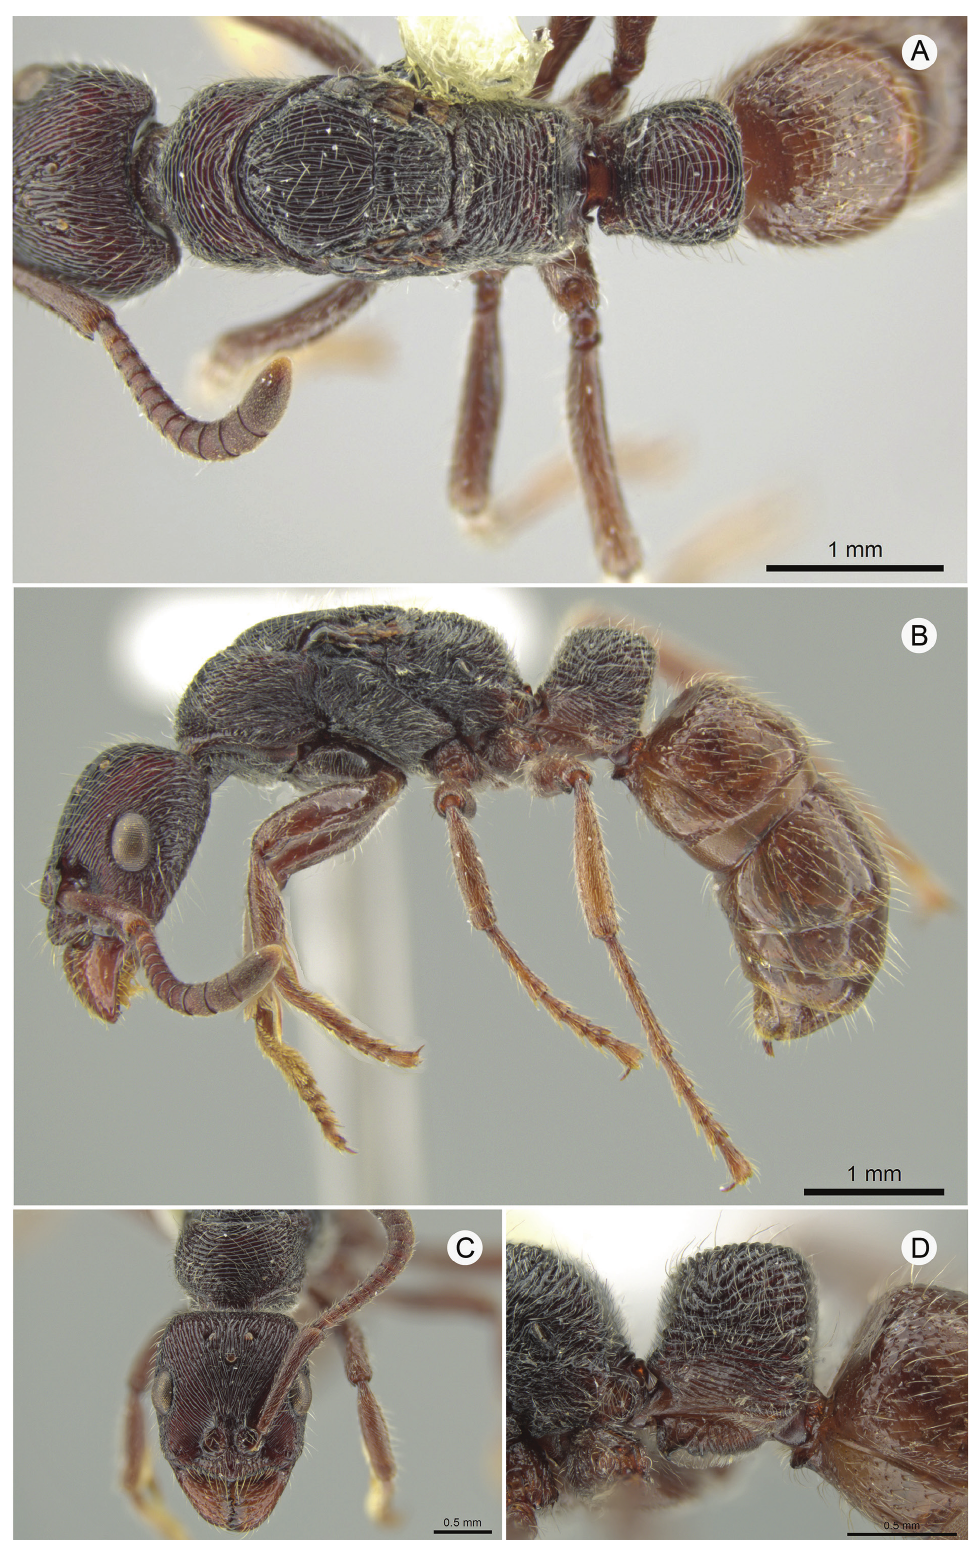
Fig. 3 . Igaponera curiosa (Mackay & Mackay, 2010), holotype queen. A . Body in dorsal view. B . Body in lateral view. C . Head in frontal view. D . Petiole in lateral view. Additional images available on AntWeb (www.antweb.org). Scale bars: A–B = 1 mm; C–D = 0.5